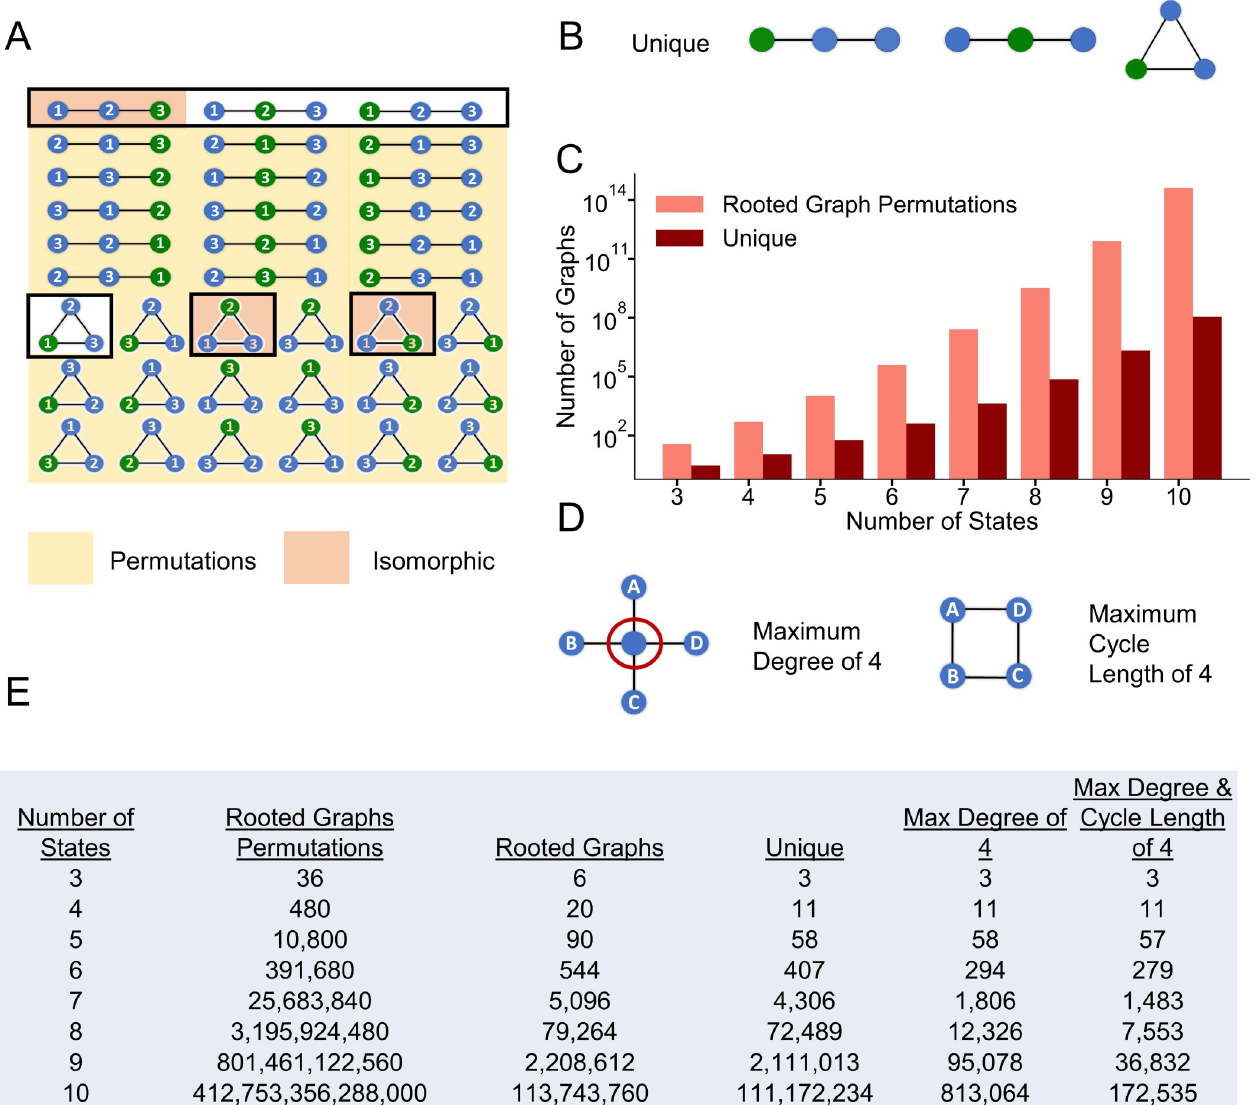
Fig 1. Reduction in model search space by enumerating unique topologies as a function of the states. A) Blue states are non-open while the open state (root) is colored green. All 36 permutations of three state rooted topologies are depicted. Permutations outlined in black represent the original six possible rooted topologies of three states. Orange shading represents the three isomorphic permutations of the six possible rooted topologies while the three unshaded topologies correspond to the unique rooted topologies as in B . The yellow shaded topologies are the remaining 30 permutations. A reduction from 36 rooted graph permutations to three unique topologies is depicted in C . C) Results of a similar graphical enumeration analysis for rooted topologies with 4+ states. D) Biophysically inspired restriction of the maximum degree in a graph to 4. Applying this restriction to the unique topologies results in a reduction in a model search space as enumerated in the table. After further restricting the maximum cycle length in a graph to size 4 after the degree restrictions, final graph counts are displayed in E as function of the number of states. E) Enumeration summary table of rooted graph permutations, rooted topologies, unique rooted topologies, and biophysical restrictions as a function of the number of